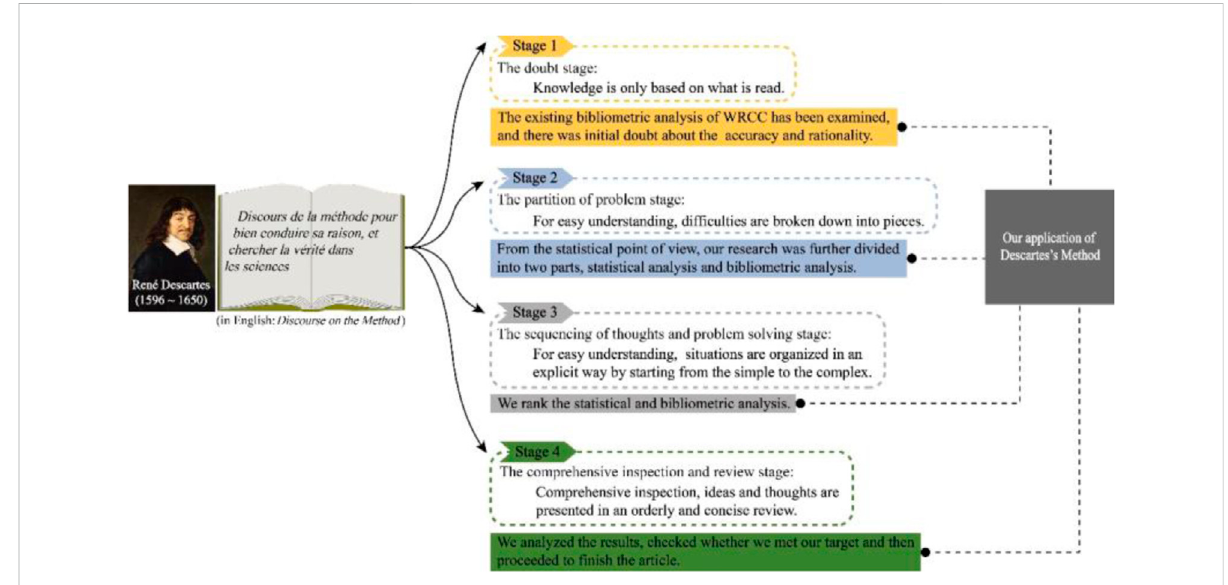
FIGURE 1 Framework and application of René Descartes ’ s Discourse on the Method. Source of René Descartes ’ s portrait: